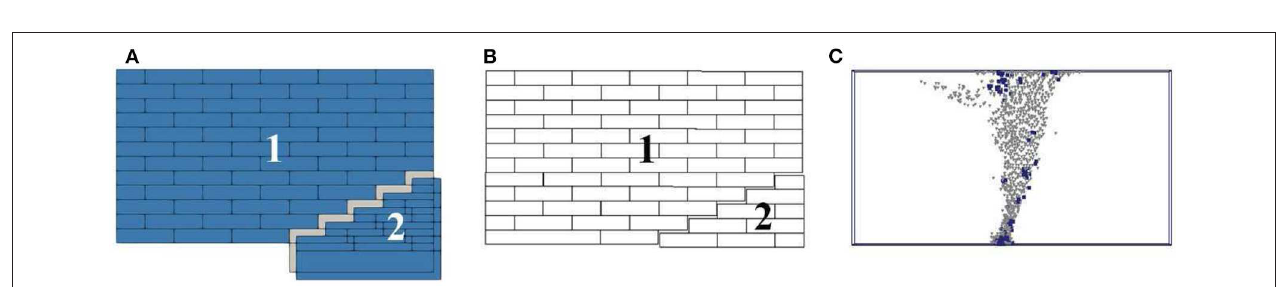
FIGURE 6 | (A) Experimental and (B) Numerical results for Test 12C. [Courtesy of Prof. F. Portioli].